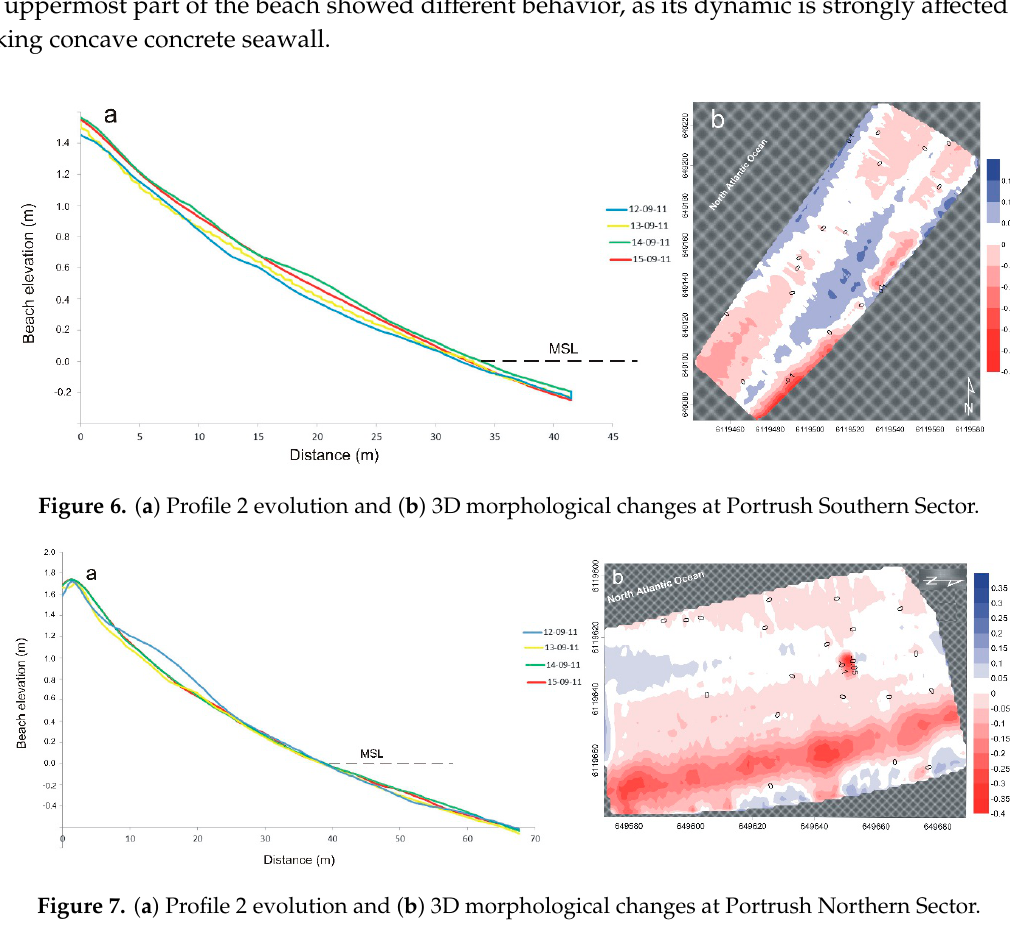
Figure 7. ( a ) Profile 2 evolution and ( b ) 3D morphological changes at Portrush Northern